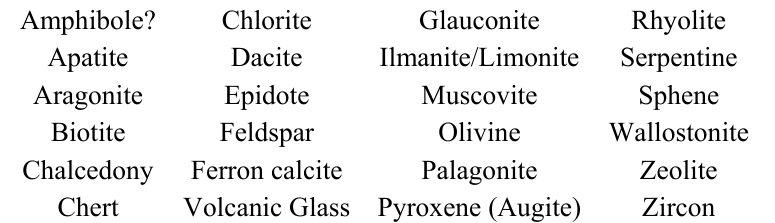
Table 1. List of rare rock fragments and minerals identified in thin section samples of sandstones examined in this